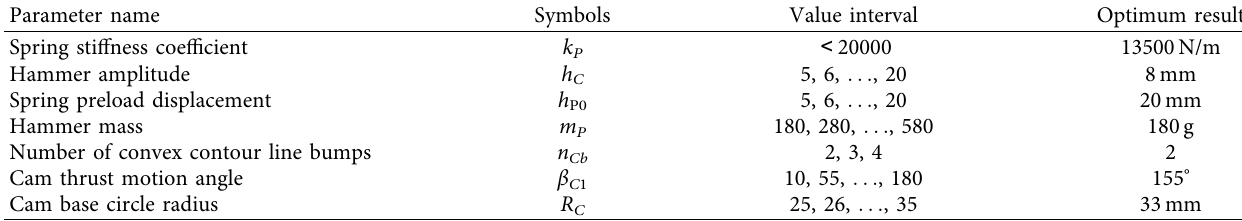
Table 2: The constraint parameters of the percussive mechanism.